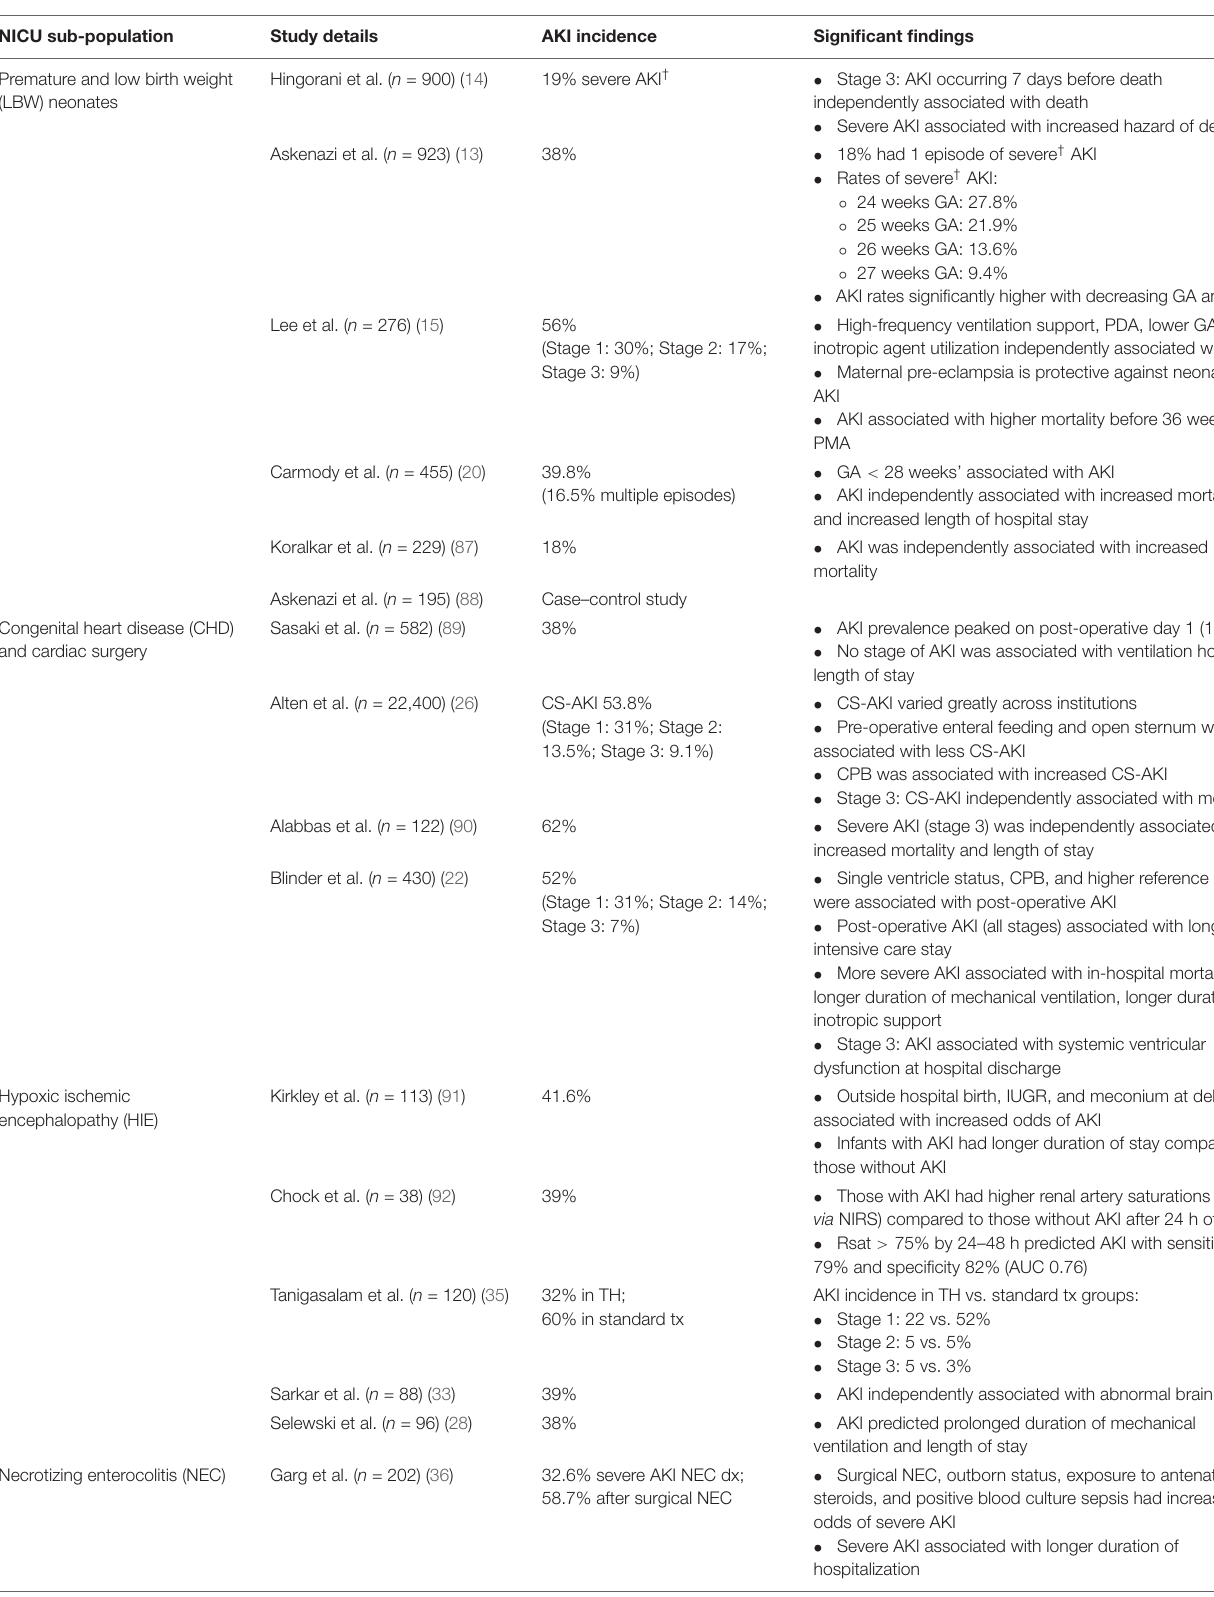
TABLE 2 | Epidemiology of high risk populations for neonatal acute kidney injury. NICU